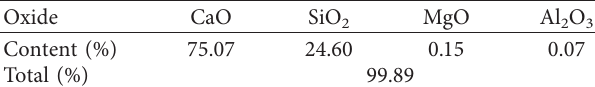
Figure 2: Particle size of C 3 S. Table 1: Chemical composition of C 3 S samples by XRF analysis.